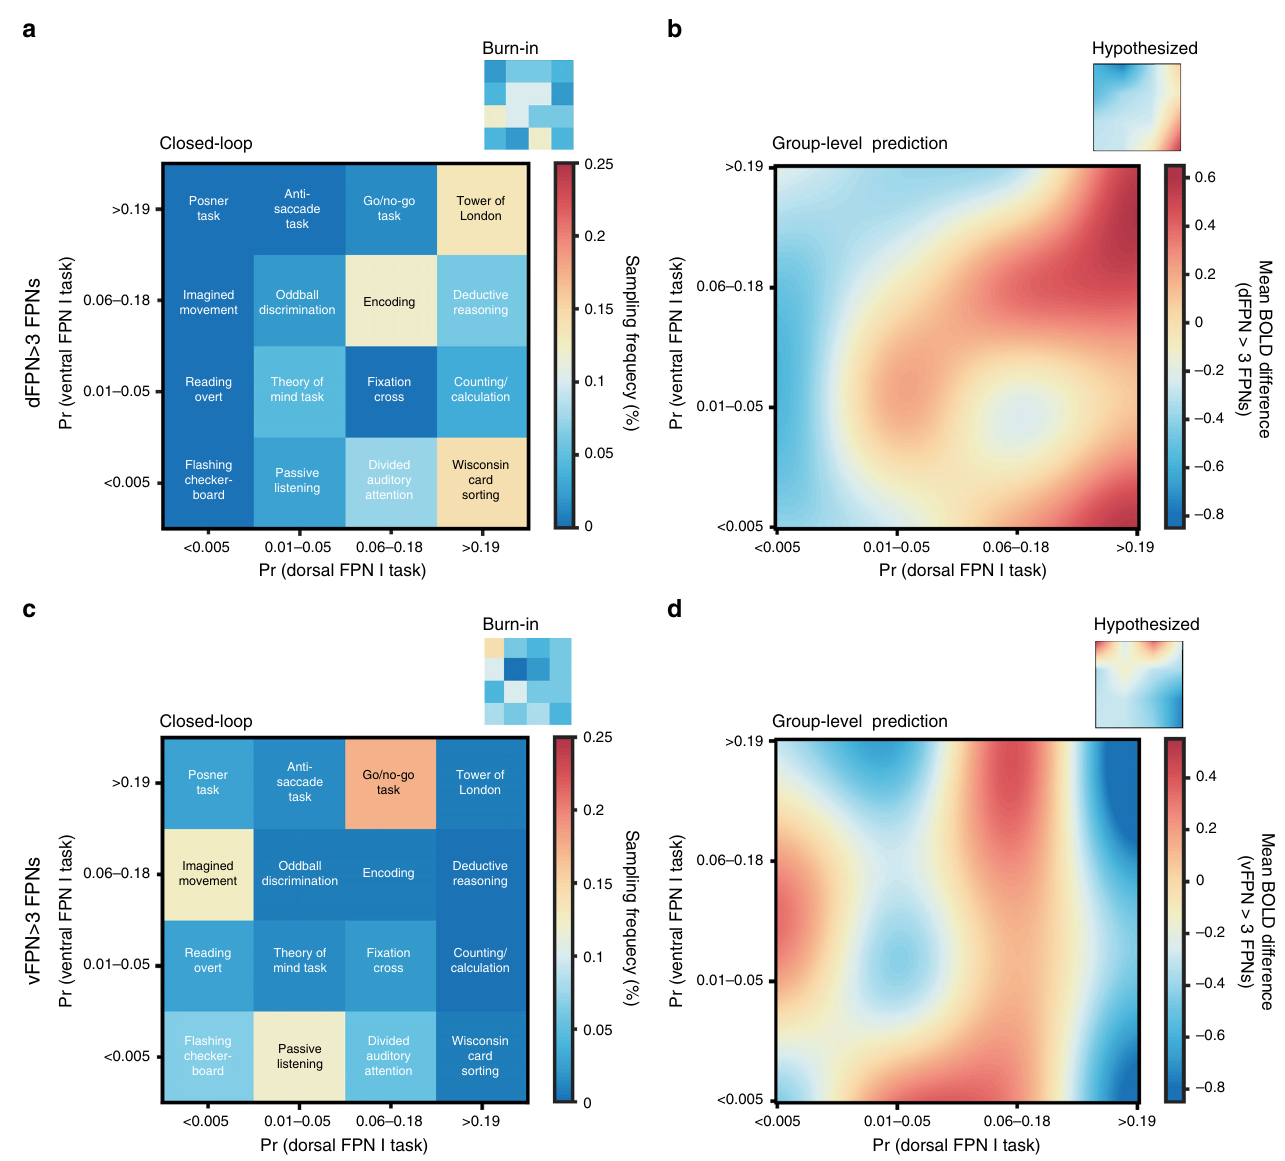
Fig. 5 Group-level results of Experiment 3. a For the contrast dFPN > all other three FPNs, the Tower of London, Wisconsin Card Sorting, and Encoding tasks were most frequently sampled by neuroadaptive Bayesian optimization. b Group-level predictions across the task space equally show the Tower of London, Wisconsin Card Sorting and Encoding tasks to be optimal for dissociating the dFPN from the other FPNs, in addition to the Deductive Reasoning task. c For the contrast vFPN > all other three FPNs, the Go/No-go, Passive Listening and Imagined Movement tasks were most frequently sampled by neuroadaptive Bayesian optimization. d Group-level predictions across the task space equally show the Go/No-go, Passive Listening and Imagined Movement tasks to be optimal for dissociating the vFPN from the other FPNs, in addition to the Reading and Divided Auditory Attention comparison between the dFPN/vFPN and the three remaining FPNs across the entire task space (Fig. 6). For the sake of com- pleteness, we also computed each contrast between the two FPNs added in Experiment 3 and the three remaining FPNs (Fig. 6 — see Component 05 and Component 06). For all FPNs, each pairwise comparison yielded qualitatively distinct activation pro fi les across the task space. As detailed in the next paragraphs, the tasks or set of tasks identi fi ed as optimal for each single pairwise comparison, were all resembled in the average activation pro fi le of the respective networks (Fig. 6 - bottom row). This demonstrated that this target measure indeed was well suited for addressing the many-to-many mapping problem by identifying a set of tasks that uniquely differentiates one FPN from functionally highly similar FPNs.